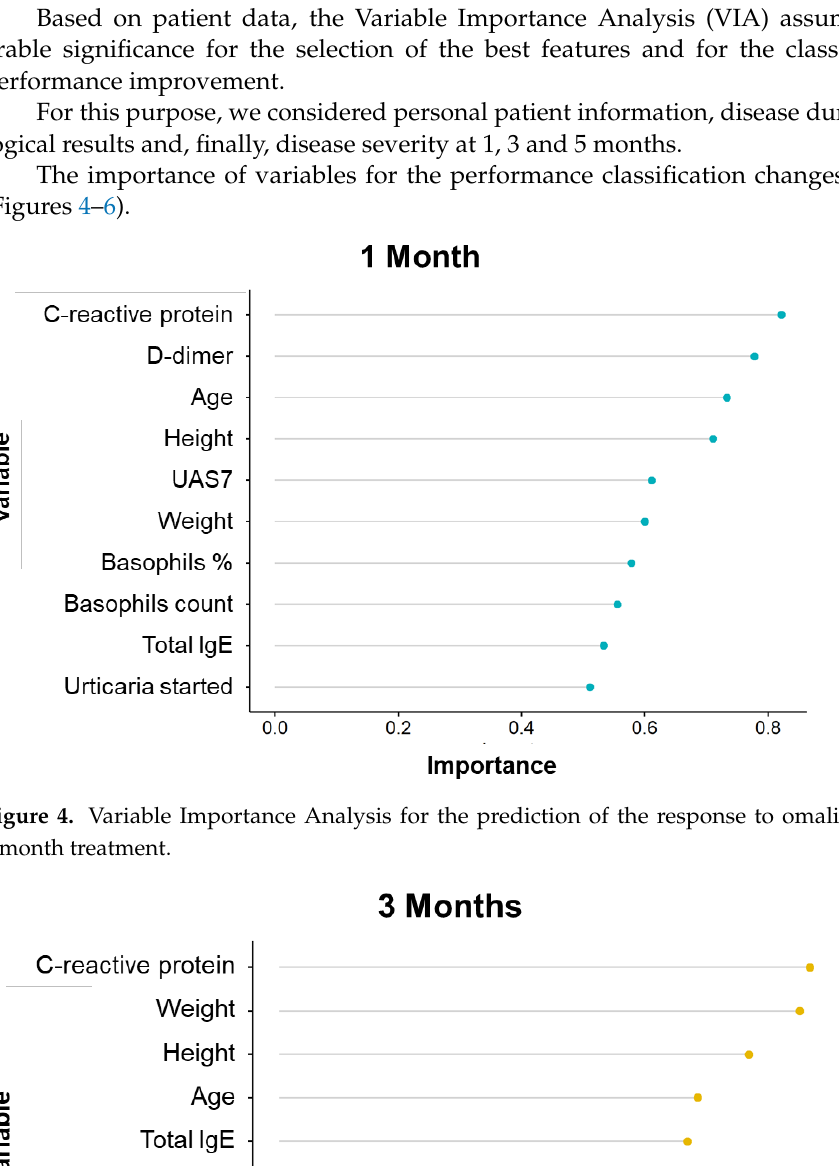
Figure 6. Variable Importance Analysis for the prediction of the response to omalizumab after 5 months treatment. However, many variables ranked similarly in the first three months of treatment, like D-dimer and C -reactive protein, followed by age, height, weight. By contrast, total serum IgE and basophils levels had a lower rank of importance. Boruta method analysis showed that only C -reactive protein is significantly associated with treatment response at 1 month (Figure 7).